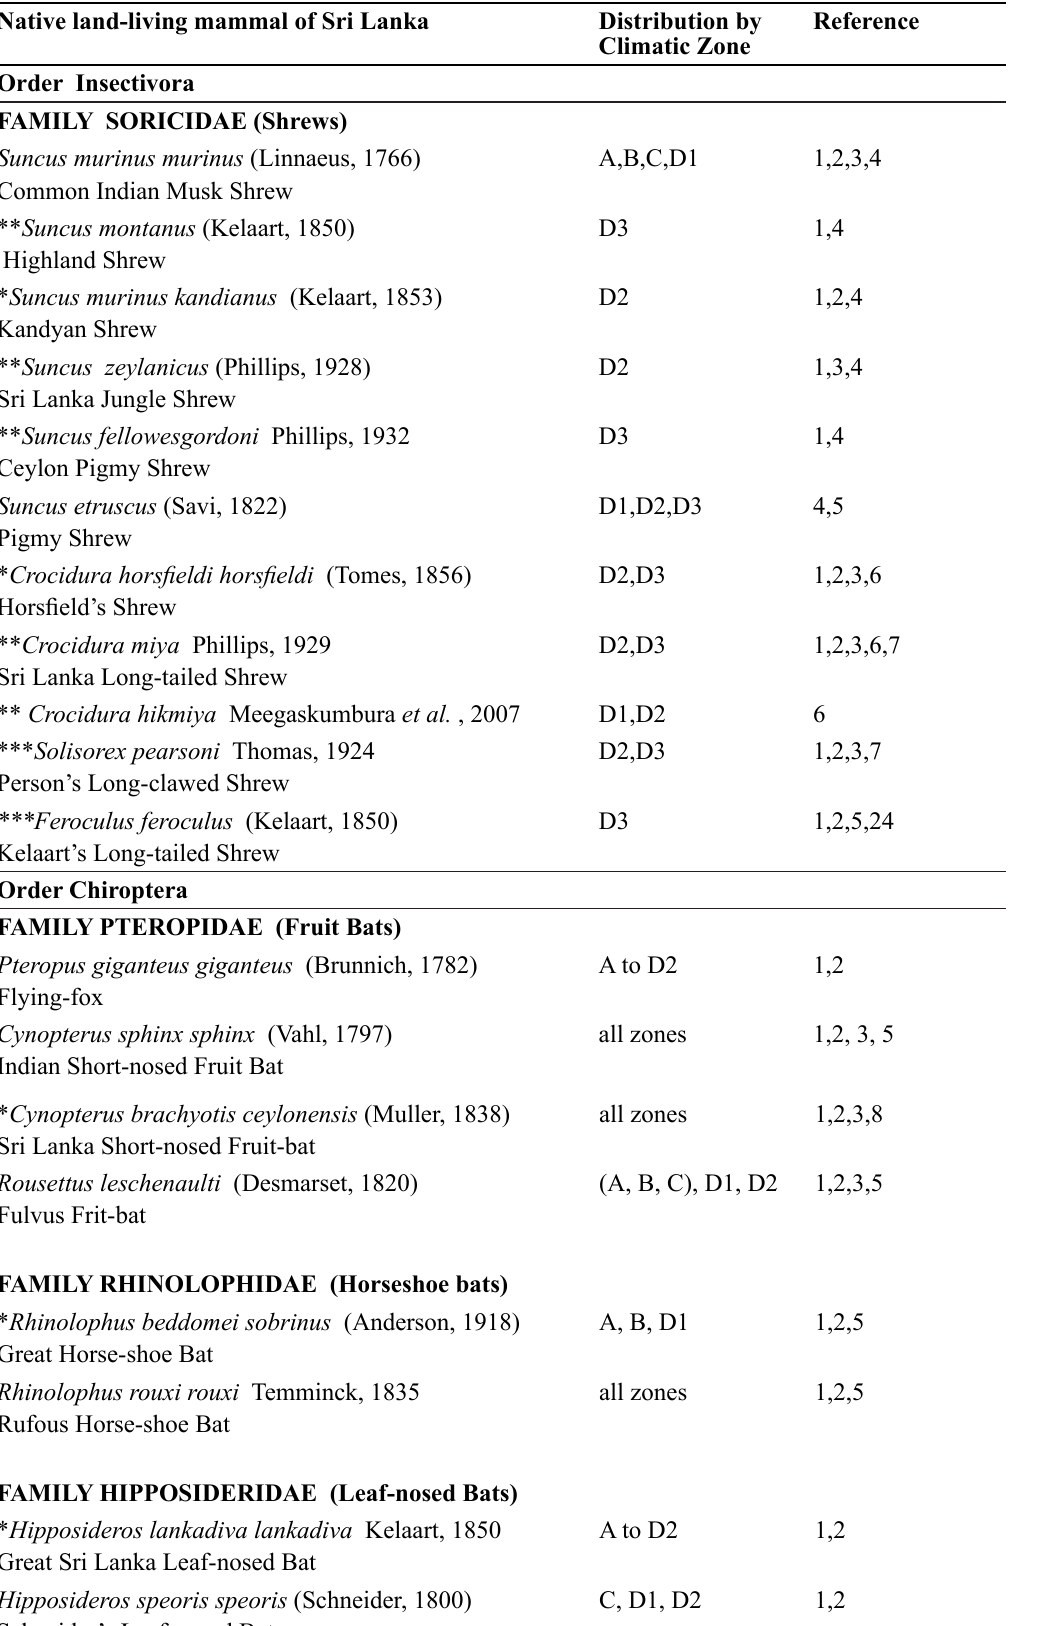
Appendix 1. List of naturally occurring land-living mammals of Sri Lanka, excluding introduced taxa†. Definitions of